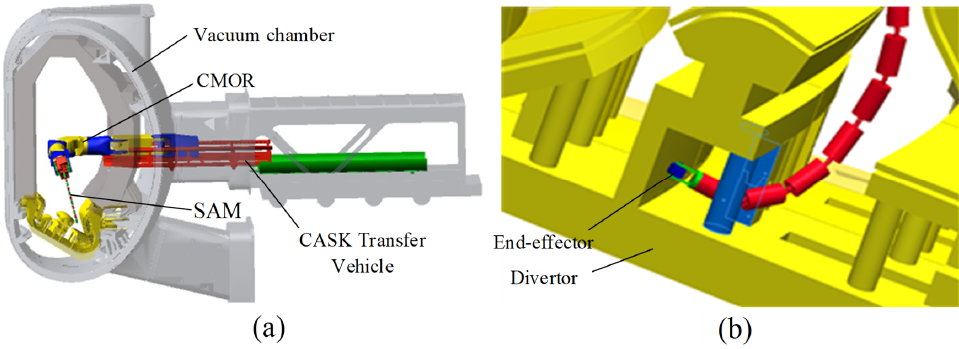
Figure 1. SAM operation process. ( a ) SAM installs the end of the CMOR into the vacuum chamber; ( b ) maintenance inspection of the divertor.